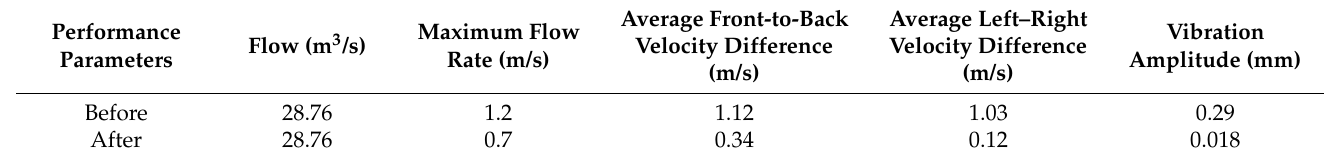
Table 3. Comparison of parameters before and after transformation (C circulating pump).